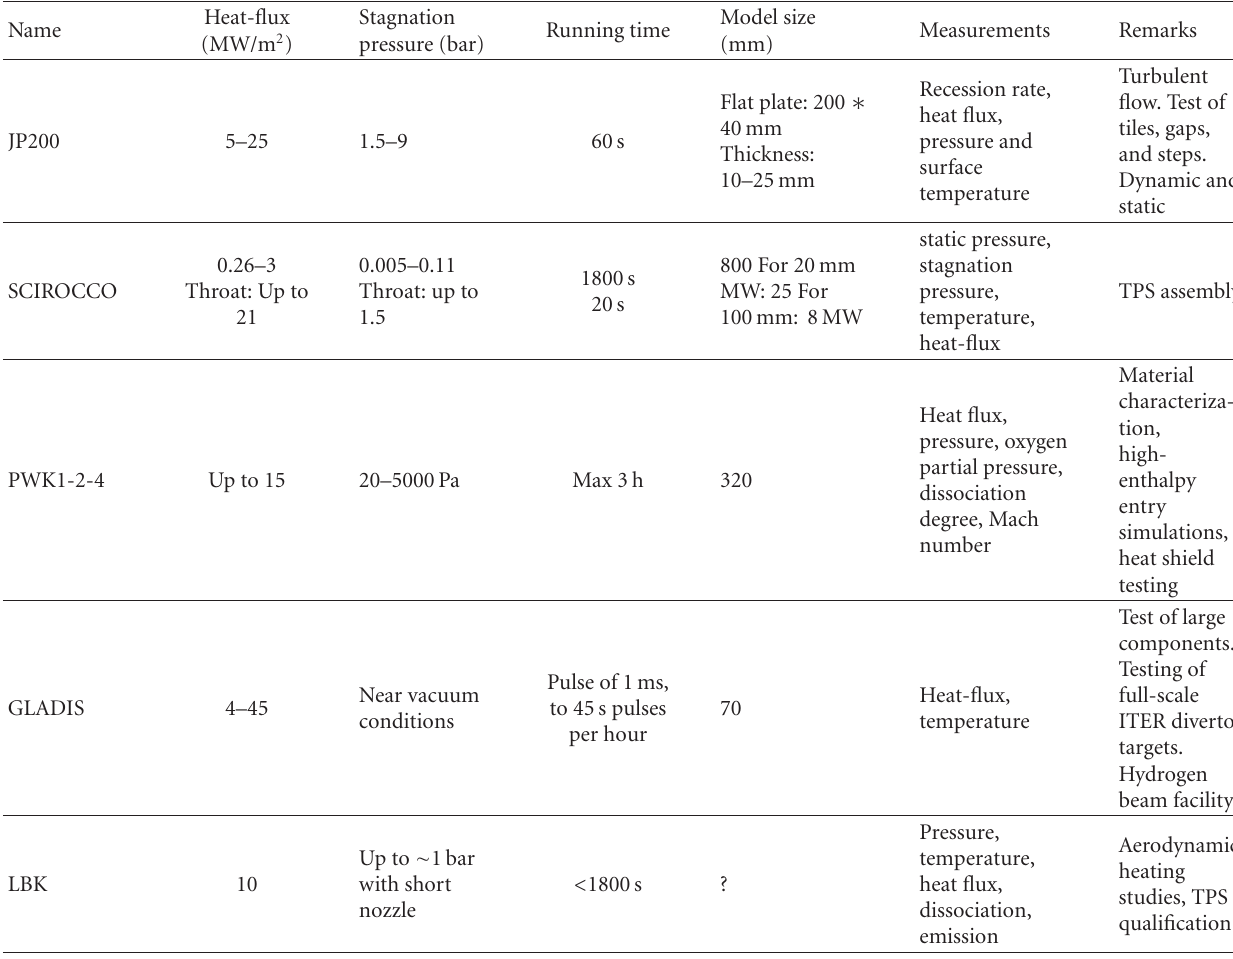
Table 7: Characteristics of facilities for TPS testing at high